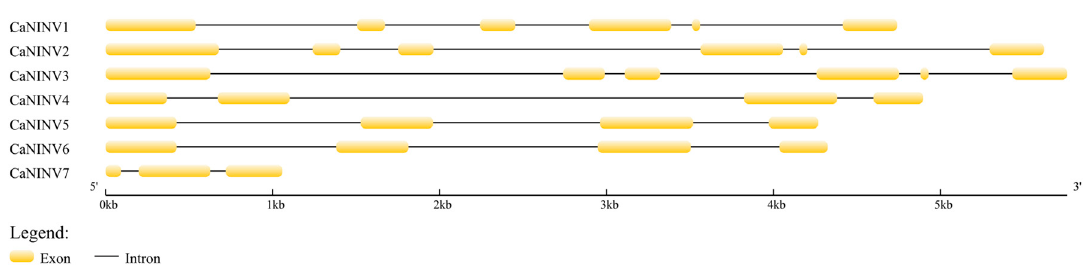
Figure 3. Exon–intron structure of the seven NINVs in pepper. Introns are shown as black lines, exons are shown as yellow boxes.